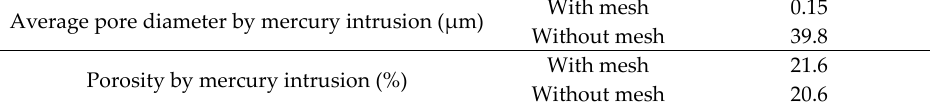
Figure 8. Porosimetry properties obtained via mercury intrusion of hydraulic lime mortar applied to hollow ceramic brick substrate, with and without mesh. Table 7. Hydraulic lime mortar applied to the concrete slab substrate.